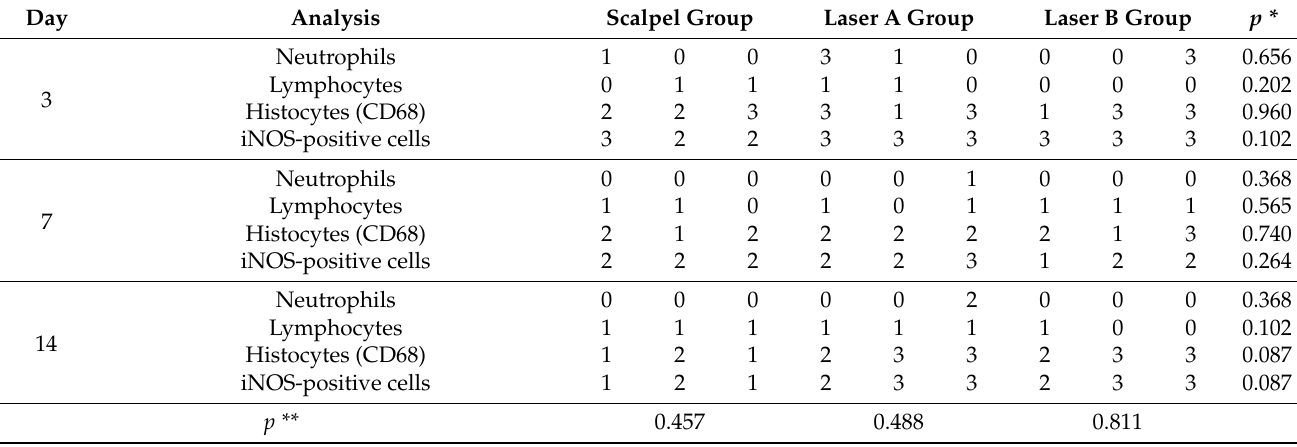
Table 1. Result of histologic and immunohistochemical analyses.